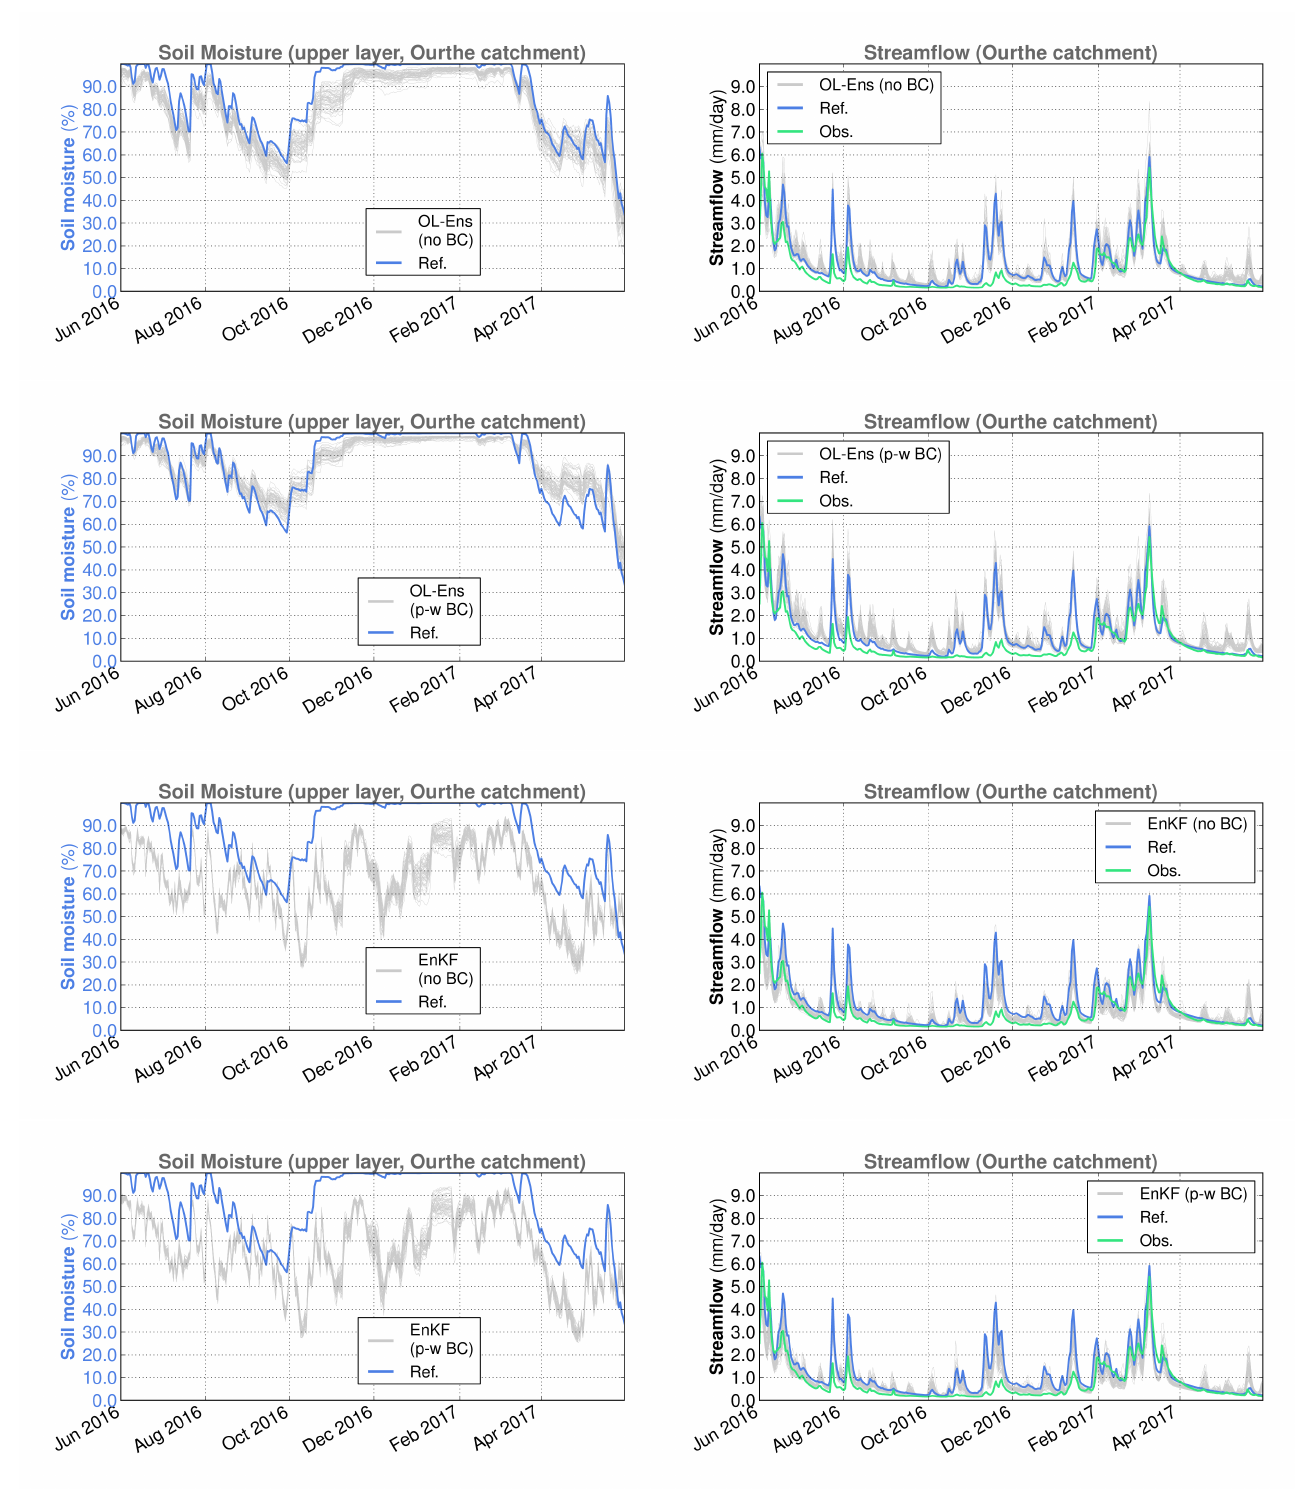
Figure 10. Spatially averaged surface soil moisture (reference simulation and ensemble members) and streamflow (reference simulation, observations and ensemble members) for the Ourthe catch- ment in SCHEME model simulations, June 2016–May 2017. From top to bottom: OL without bias correction, OL with piece-wise bias correction, EnKF without bias correction, EnKF with piece-wise bias